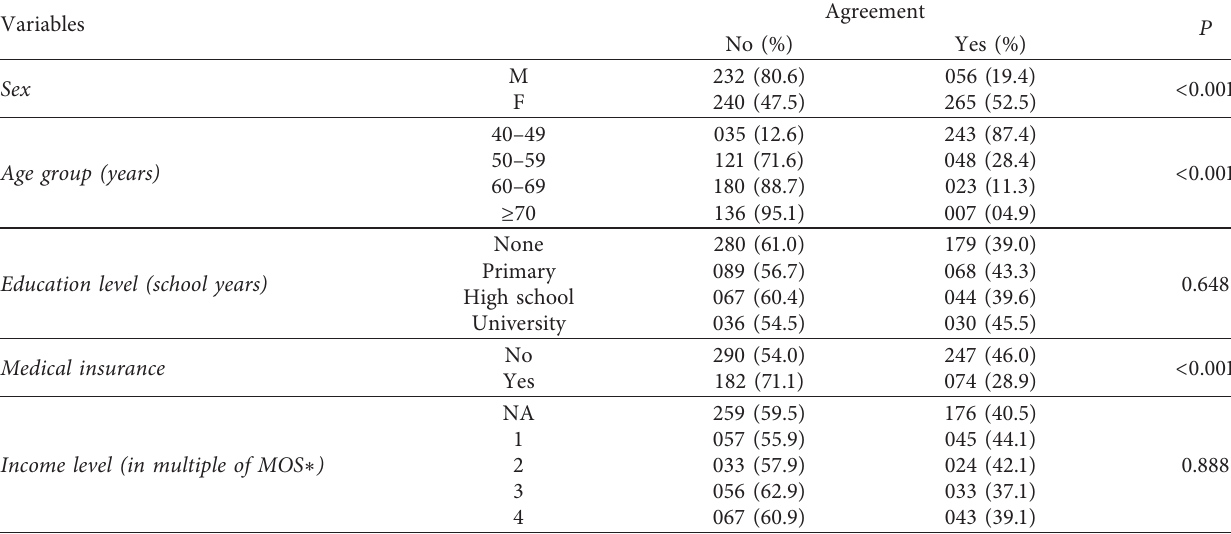
Table 5: Distribution of characteristics according to agreement status of 793 patients in the cardiology unit of the UH-GT.